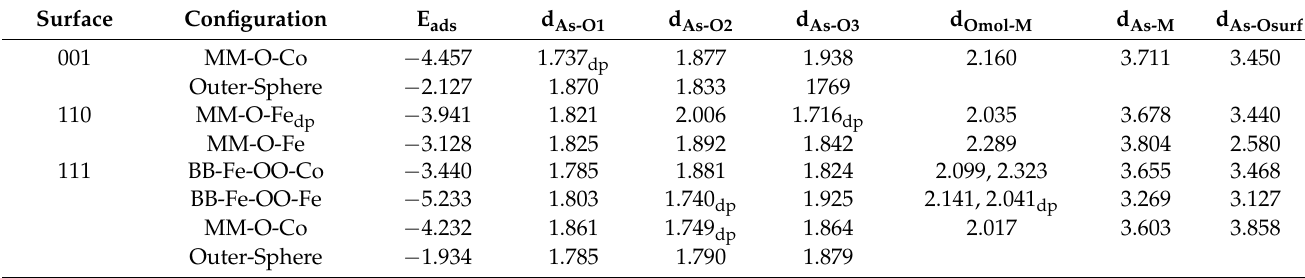
Table 2. Adsorption energies (eV) and interatomic distances (Å) of each uniquely identified optimised geometry of H 3 AsO 3 on hydroxylated Fe 2 CoO 4 (001), (110), and (111) surfaces (dp = deprotonated, M = nearest surface Fe or Co cation).